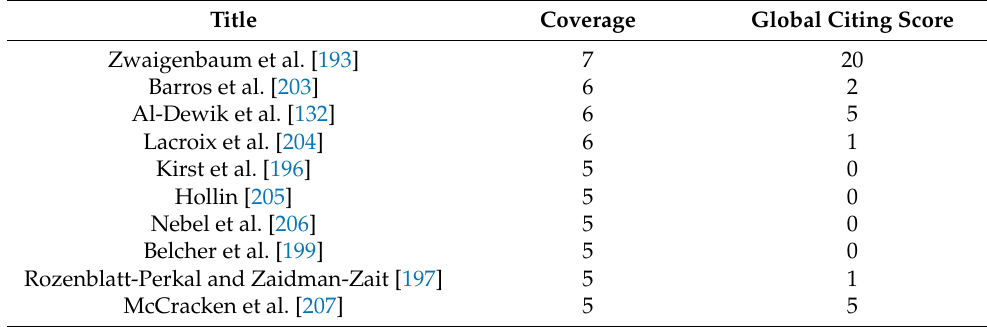
Table 13. Top 10 citing papers in Cluster #10 identified using DCA.